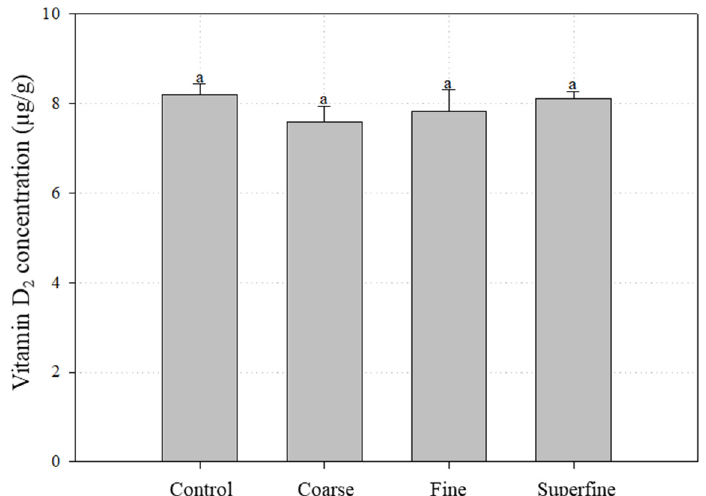
Figure 5. Effect of particle size reduction on the vitamin D 2 concentration of mushroom powders. The control mushrooms were UV-B irradiated (30 min) and freeze-dried. Coarse fine and superfine mushroom powders were prepared using the control mushrooms. All values were expressed as the mean ± standard deviation of triplicate analysis. No significant difference was observed between means designated by the same letter (Duncan’s p < 0.05).